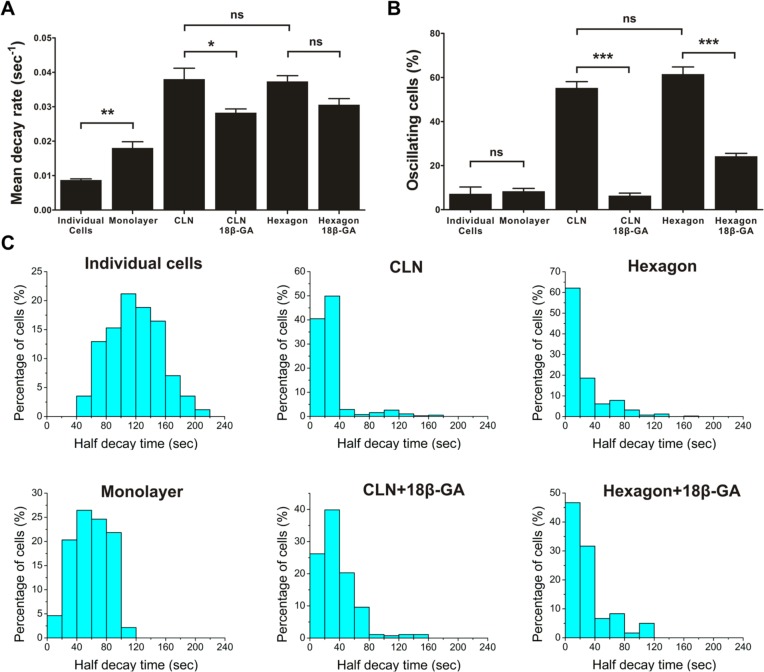
Architecture-dependent calcium signaling is mediated through gap junctions.(A-B) Quantification of the mean decay rate of the initial calcium spike and calcium oscillation occurrence rate in various configurations in the presence or absence of 18β-GA, a gap junction blocker. Data represent mean ± s.e.m. (Bonferroni's multiple comparison test; ns, not significant; *, P<0.05; **, P<0.01; ***, P<0.001; n = 6 for individual cells; n = 3 for CLN; n = 3 for CLN with 18β-GA; n = 8 for hexagon; n = 3 for hexagon with 18β-GA). (C) Histograms of the half decay times of the initial calcium spikes. Total cells analyzed were 256, 2776, 466, 377, 884, and 324 for individual cells, monolayer, CLN, CLN with 18β-GA, hexagon, and hexagon with 18β-GA respectively.